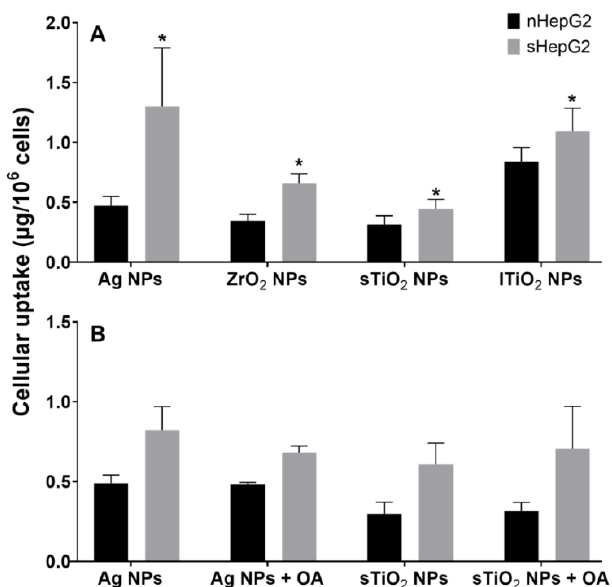
Figure 7. Differential cellular uptake of MNPs by nHepG2 and sHepG2. ( A ) Amounts of NPs in nHepG2 and sHepG2 cells after a 24-h incubation with 4 μg /mL Ag NPs, ZrO 2 NPs, sTiO 2 NPs or lTiO 2 NPs. ( B ) Cell uptake of NPs by nHepG2 and sHepG2 cells following the treatments with Ag NPs or sTiO 2 NPs for 3 h with/without the supplement of OA. Data were shown as means ± s.d., n = 3. * p < 0.05, compared with the amounts of NPs in nHepG2 cells with the same treatment.